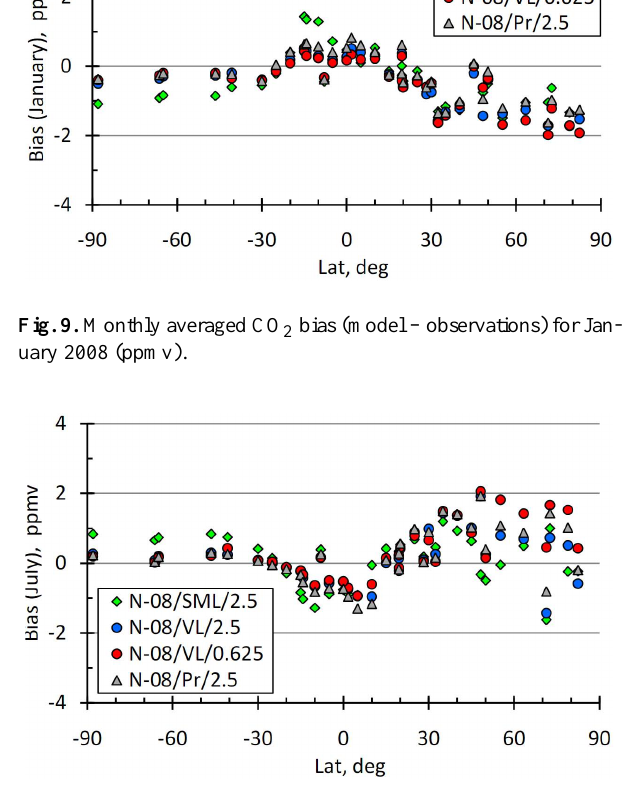
Fig. 10. Monthly averaged CO 2 bias (model – observations) for July 2008 (ppmv).